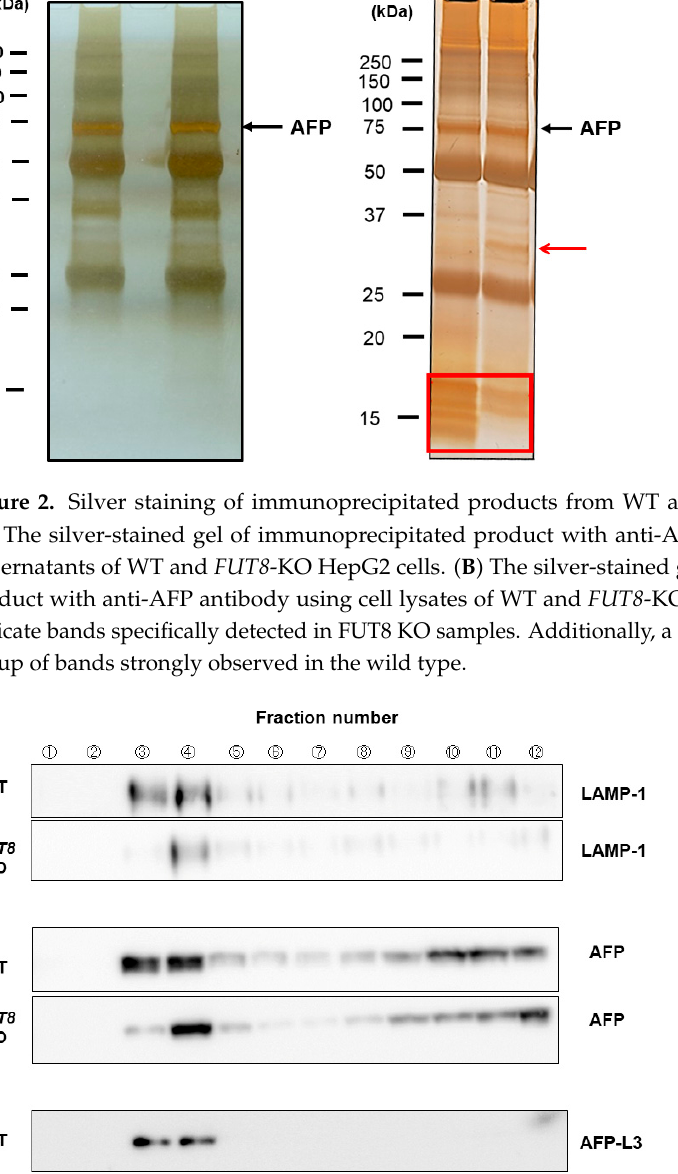
FUT8 -KO HepG2 cells.